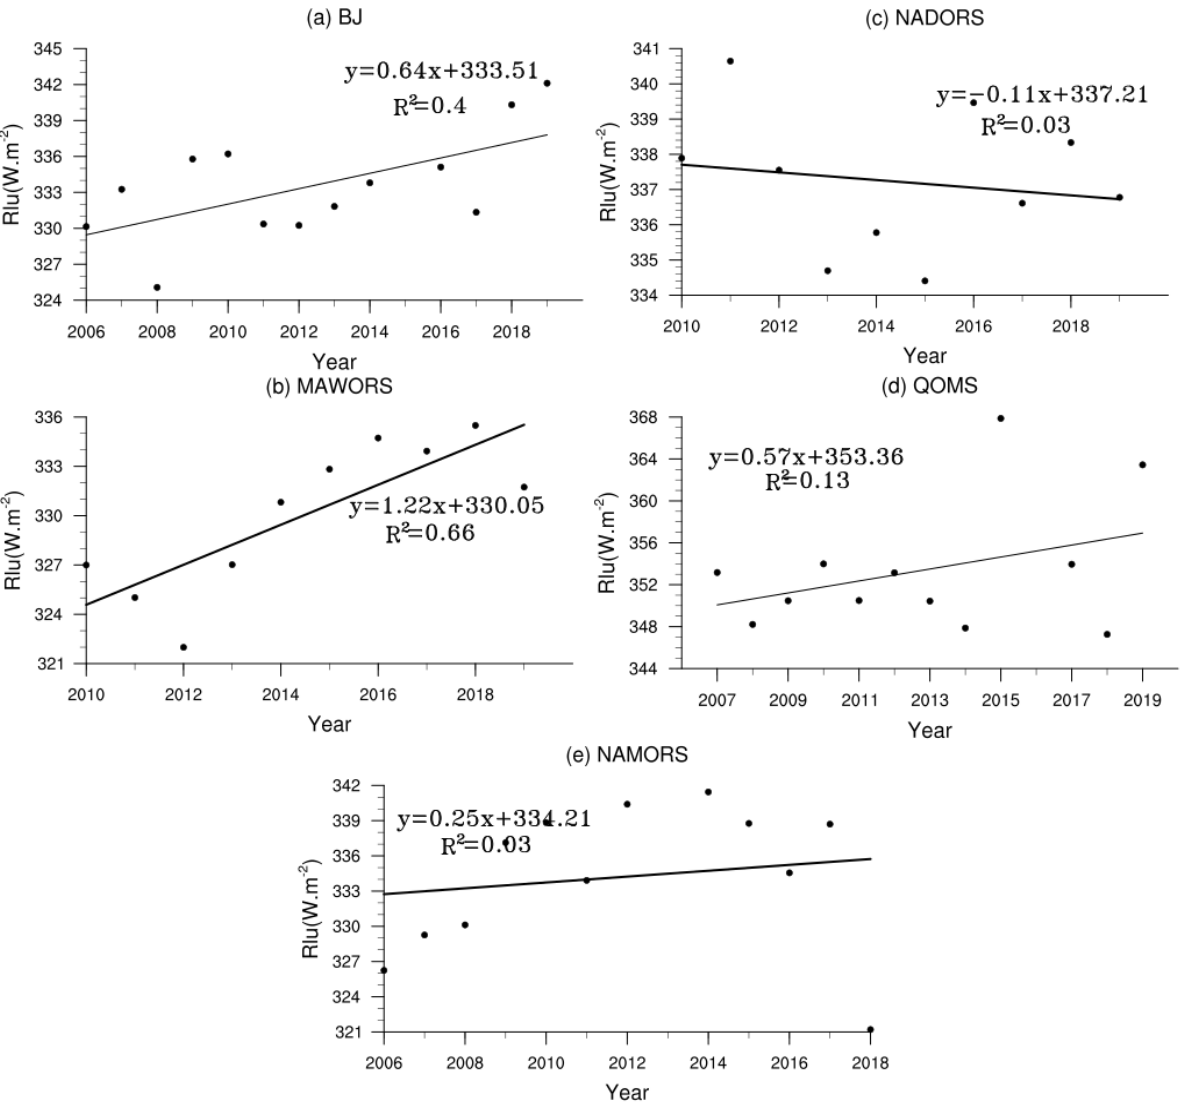
Figure 16. Interannual variation of upward longwave radiation at each station. The annual variations in upward longwave radiation (Figure 17a) revealed obvious seasonal signals at each station, in which upward longwave radiation was significantly smaller in winter than in summer. Monthly maxima varied between the different stations: upward longwave radiation peaked at BJ in July and August, at QOMS and NAMORS in June, and at NADORS and MAWORS in July. The maximum varied between 380 W · m − 2 and 410 W · m − 2 . Due to the different surface characteristics and geographic locations, the upward longwave radiation changes showed varying patterns between different stations. However, in general, the upward longwave radiation at all stations reached the maximum in summer and the minimum in